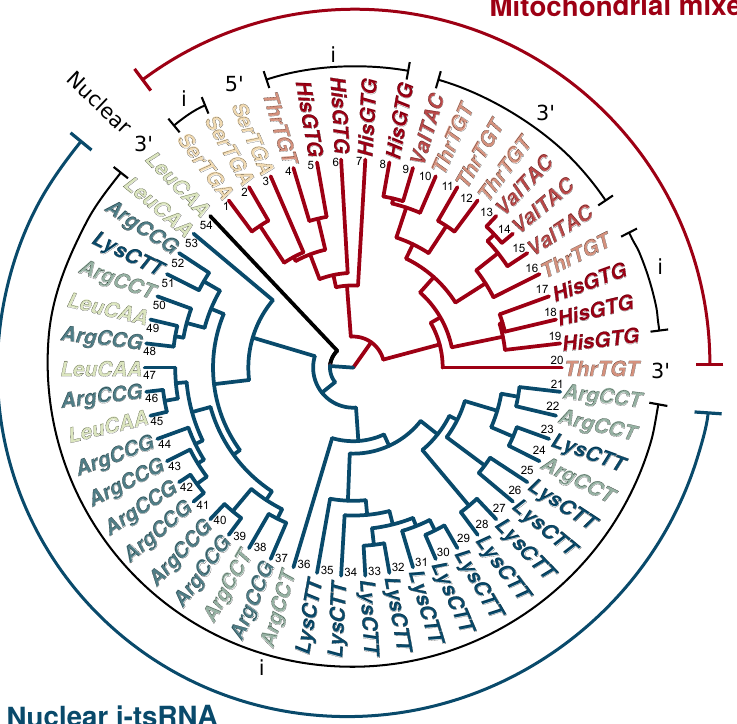
Fig 3. Mitochondrial and nuclear tsRNA form distinct clusters. Dendrogram shows the relatedness of the regulatory responses of individual tsRNAs from the significantly changed tRNA isodecoders in (Fig 2H). Each leaf represents the differences between Sugar and Healthy in a single tsRNA across the 15 participants. Mitochondrial (red) and nuclear i- tsRNAs (blue) shows clear division into 2 clusters. Hierarchical cluster analysis was based on Euclidean distances across center scaled RPM differences between the Sugar and the Healthy sample of each participant. For more information about these tsRNAs, see S5 Table. The graph can be reproduced using the script in S1 Text with input from S2 Data. RPM, reads per million; tsRNA, tRNA-derived small